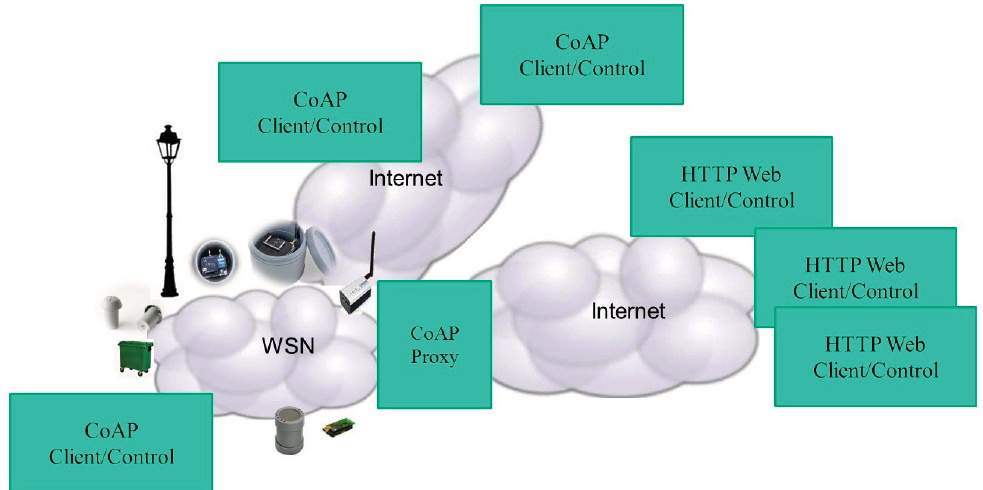
Figure 3. CoAP and HTTP access and actuation in a Smart City